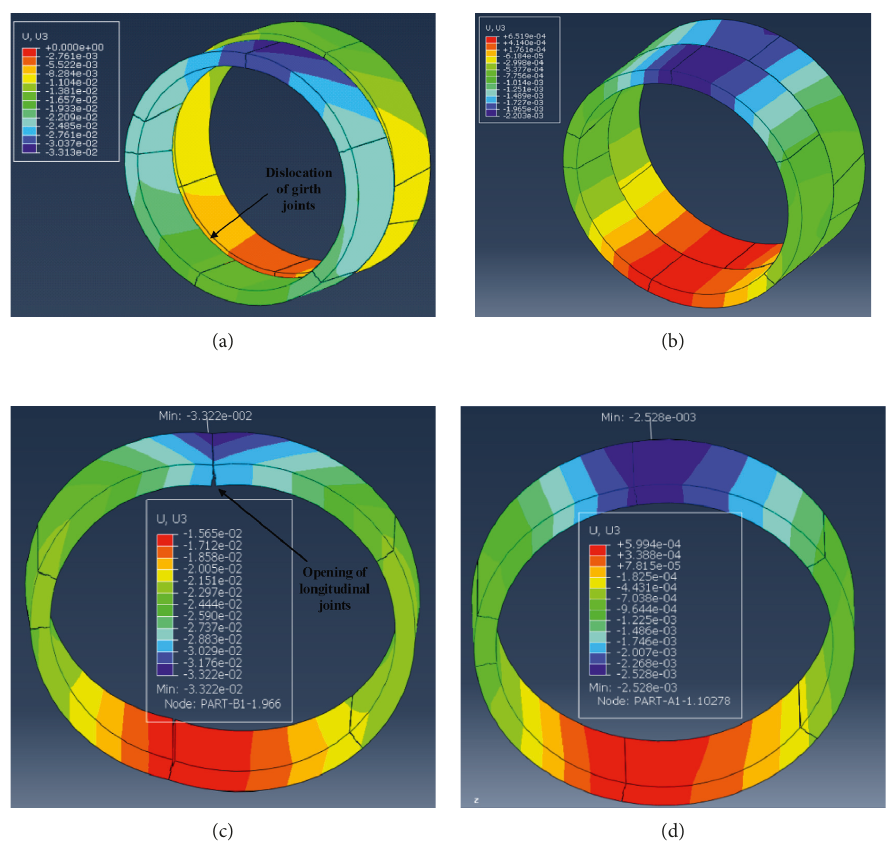
Figure 11: The effect of water inrush on segment deformation. Water head difference of (a) 18 m (20x) and (b) 0 m